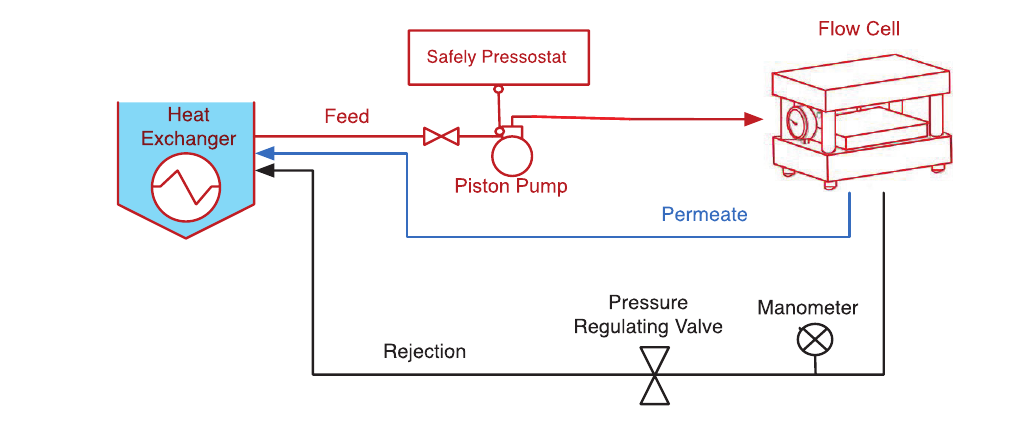
Fig. 3 – Evolution of relative permeate flux (Q/Q rejection (F/%) in the fouling